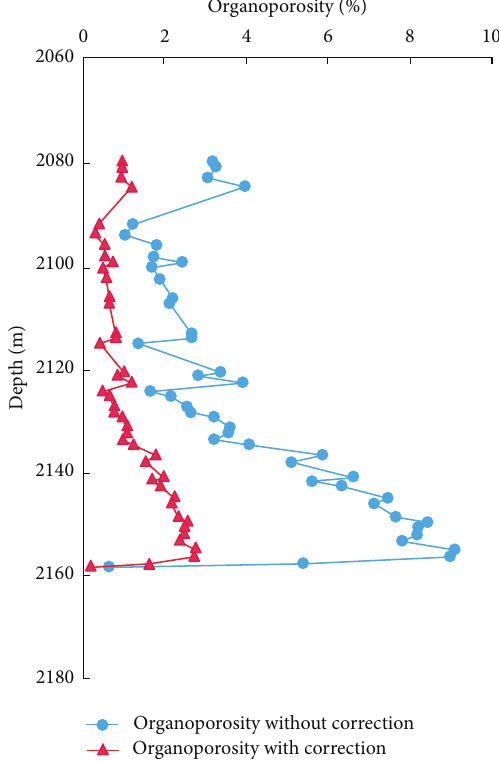
Figure 7: The organic porosities of the Py1 well from Longmaxi Shale in southeast